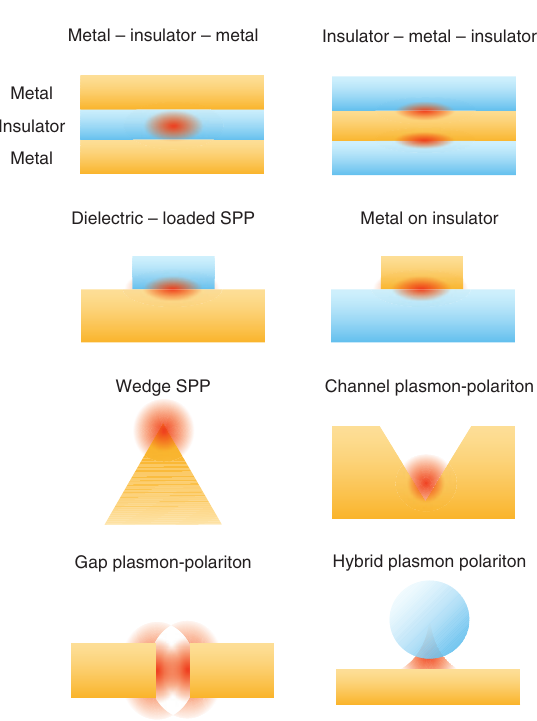
Figure 3: Cross sections of different types of plasmon waveguides (adapted from Ref.